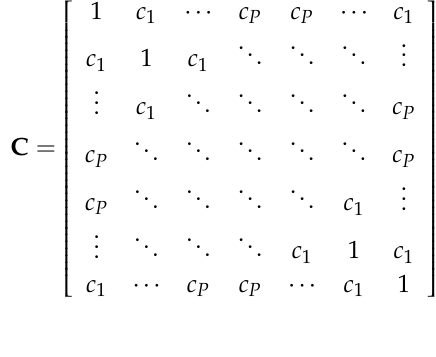
Figure 8. RMSEs of the range estimates versus SNR.